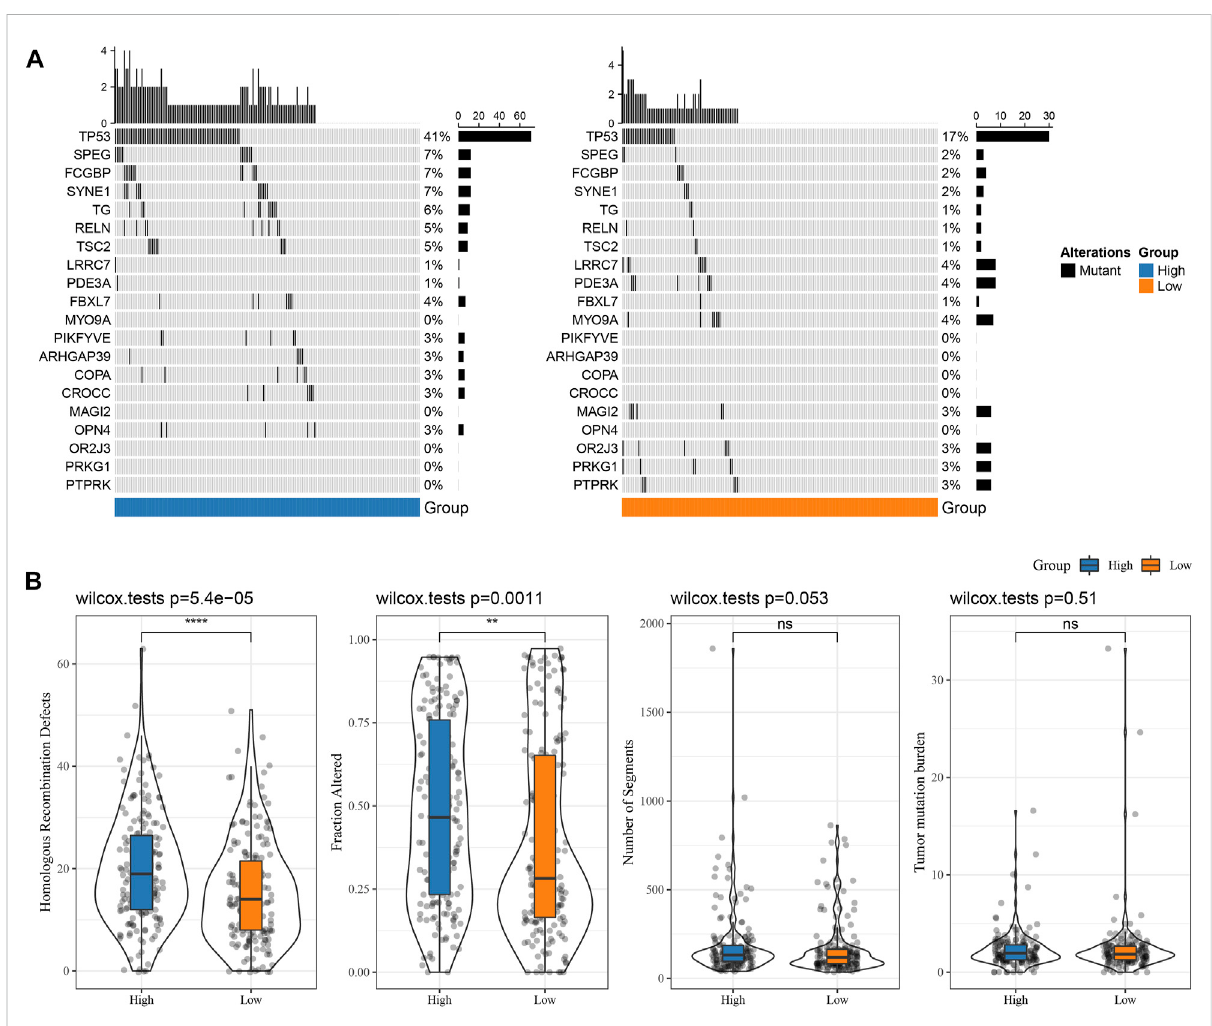
FIGURE 6 Genome changes of RS groups in TCGA cohort. (A) Somatic mutation analysis of various RS groups in TCGA cohort ( fi sher ’ s exact test); (B) Differences in Homologous Recombination Defects, Fraction Altered, Number of Segments, and Tumor mutation burden in different RS groups of TCGA cohort. (ns, p > 0.05; * * *, p < 0.001; * *, p < 0.01; *, p <